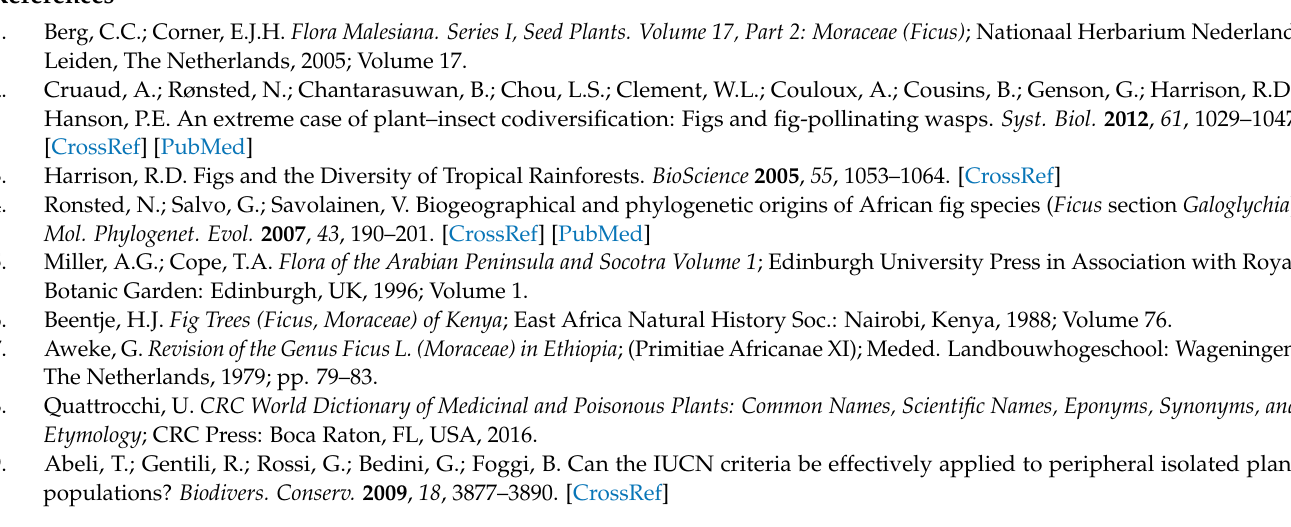
tome; Table S3: Codon–anticodon recognition patterns and codon usage of the F. populifolia plastome; Table S4: Predicted RNA editing site in the F. populifolia plastome; Table S5: Repeat sequences present in the F. populifolia plastome; Table S6: SSRs detected in five Ficus plastomes. Figure S1. Phylogenomic relationship of 28 Ficus species based on 78 coding genes inferred from BI